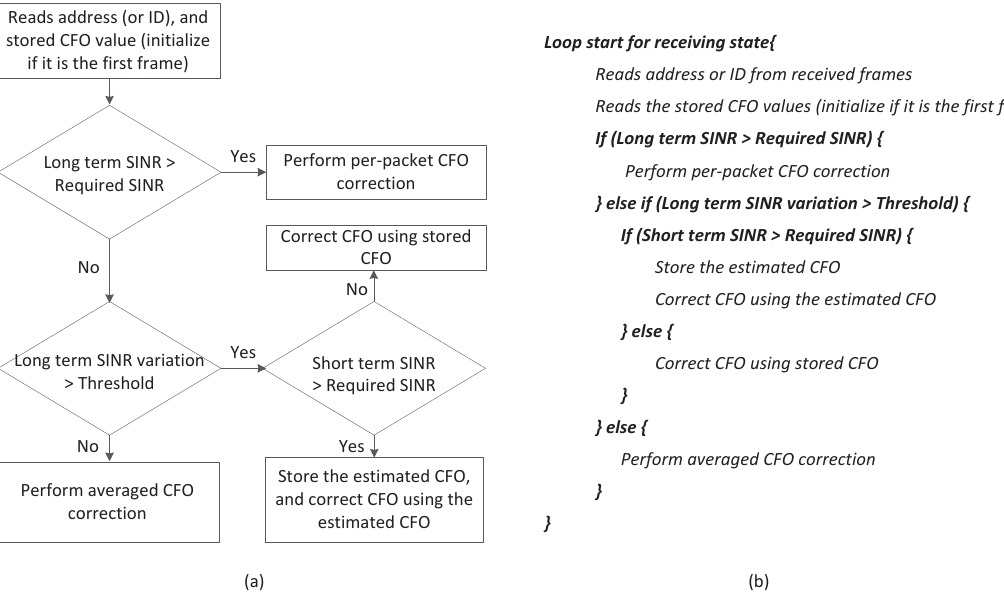
Figure 1. ( a ) flowchart and ( b ) algorithm for digital carrier frequency offset (CFO)